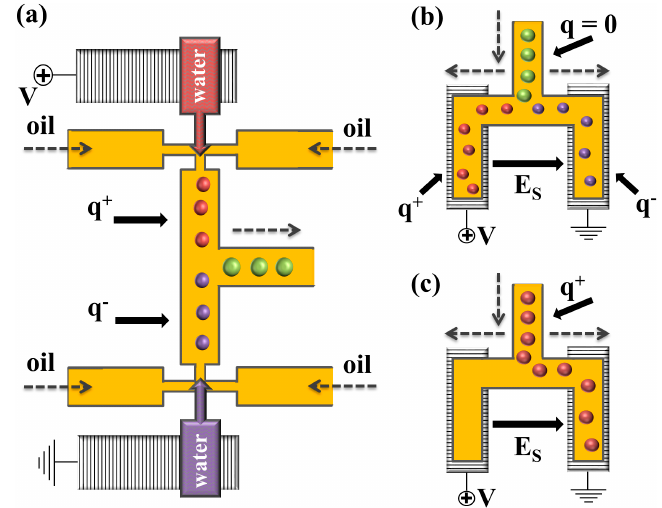
Figure 31. Electric control of charged droplets in microfluidic channels: ( a ) coalescence; ( b ) splitting control; ( c ) sorting control [179].